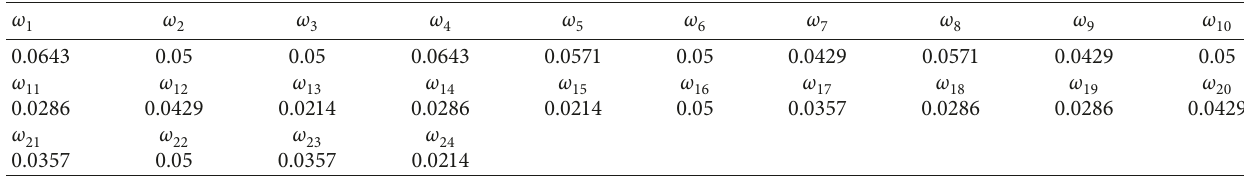
Table 6: Weights of each decision index.